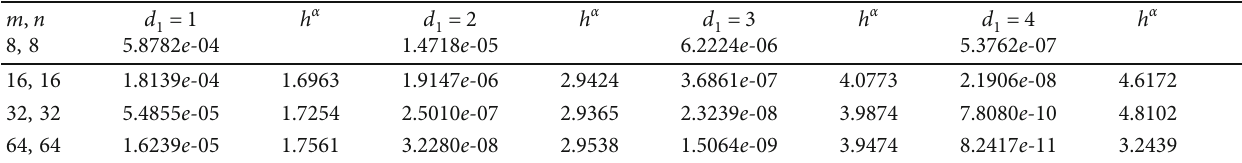
= 7 at t = 1 for equidistant nodes. 2